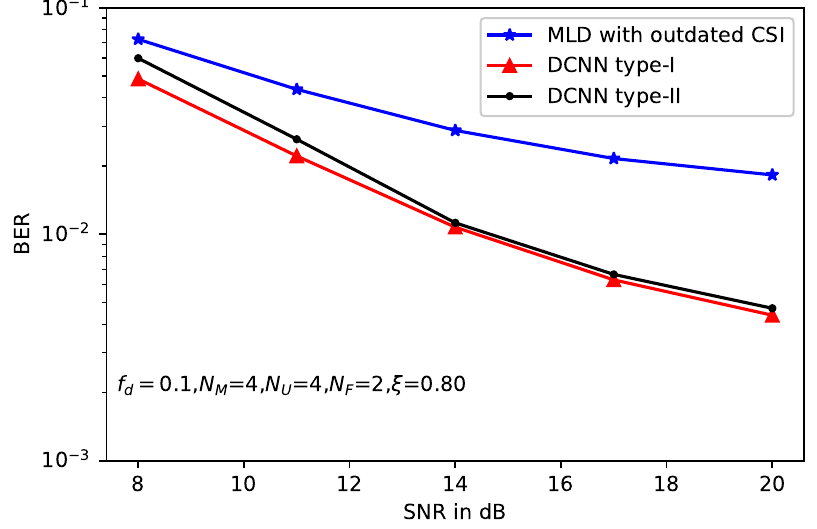
Figure 6. BER performance of deep learning-based MLD with ξ = 0.8.